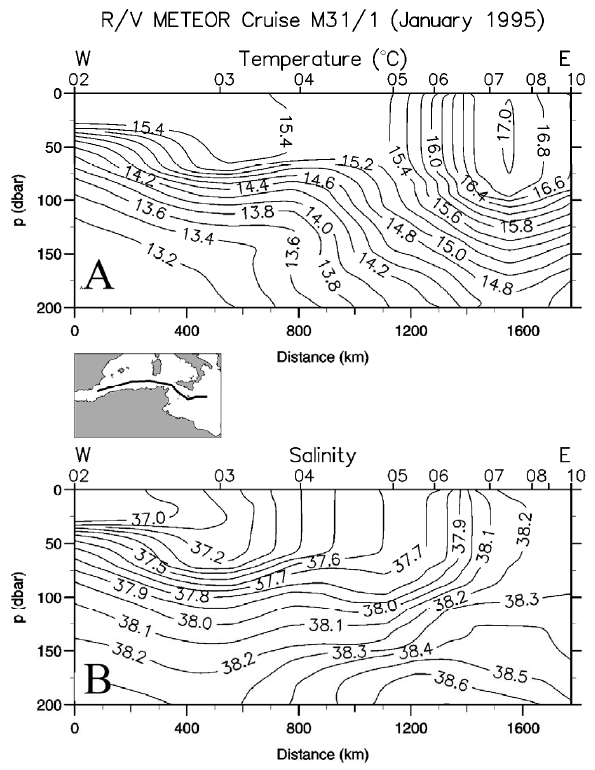
Fig. 10. Vertical distribution of (A) temperature and (B) salinity across the western Mediterranean Sea and the western part of the Ionian basin illustrating the difference in temperature and salinity on both sides of the Sicily Strait.